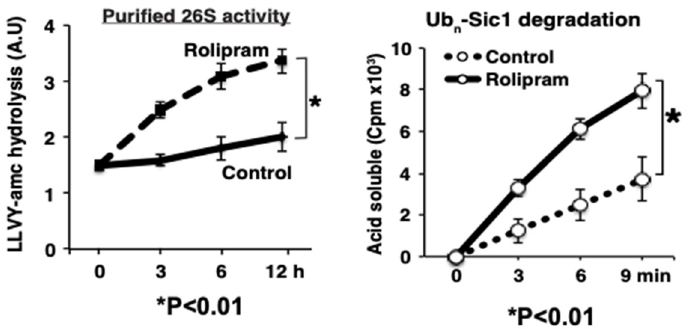
Figure 5. 26S proteasomes from mouse myotubes treated with the PDE4 inhibitor, rolipram, are more active in hydrolyzing peptides and a ubiquitinated protein. C2Cl2 myotubes were incubated with rolipram, and, at different times, samples were taken and 26S proteasomes purified by the UBL method (Left Panel). Chymotrypsin-like peptidase activity was increased in the treated cells. (Right Panel) After 6 h treatment of cells with rolipram, the purified proteasomes show a greater capacity to degrade ubiquitinated 32 P-Sic1 (adapted from [15]). (Mean of three experiments ± SEM; * denotes p < 0.01).